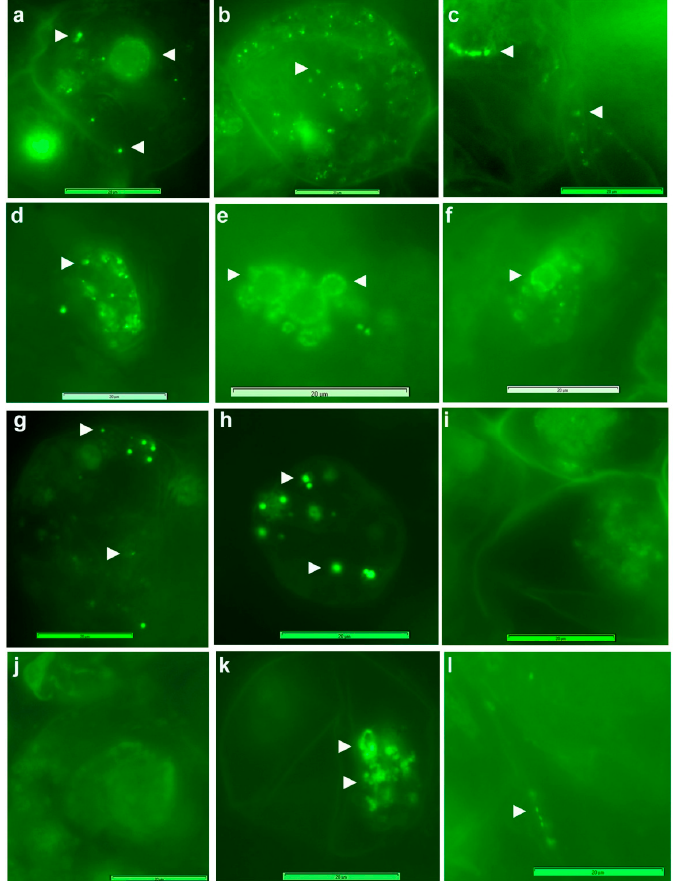
Figure 5. Fluorescent in situ hybridization (FISH) on grape suspension cells using FAM 5 ′ -labeled 16S/23S rRNA gene probes (100× objective). ( a , b ) FISH with Eub338 probe showing intracellular bacteria in the cell matrix and around nucleus, ( c , d ) along the plasma membrane, and ( e , f ) around plant organelles; ( g , h ) hybridization with EubII+III detecting some larger size cocci in the cytoplasm, ( i ) cells subjected to FISH using FAM-negative control Eub338ns, ( j ) auto-fluorescence testing, ( k , l ) FISH with LGC354ab showing Firmicutes in cytoplasm, around the organelles and along the plasma membrane indicated by bacterial detection, the extent of which is reflected in the color shade of the scale